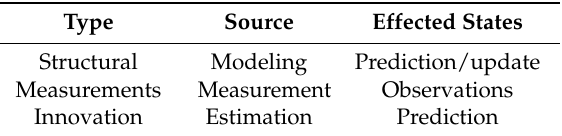
Table 1. Types of outliers in state